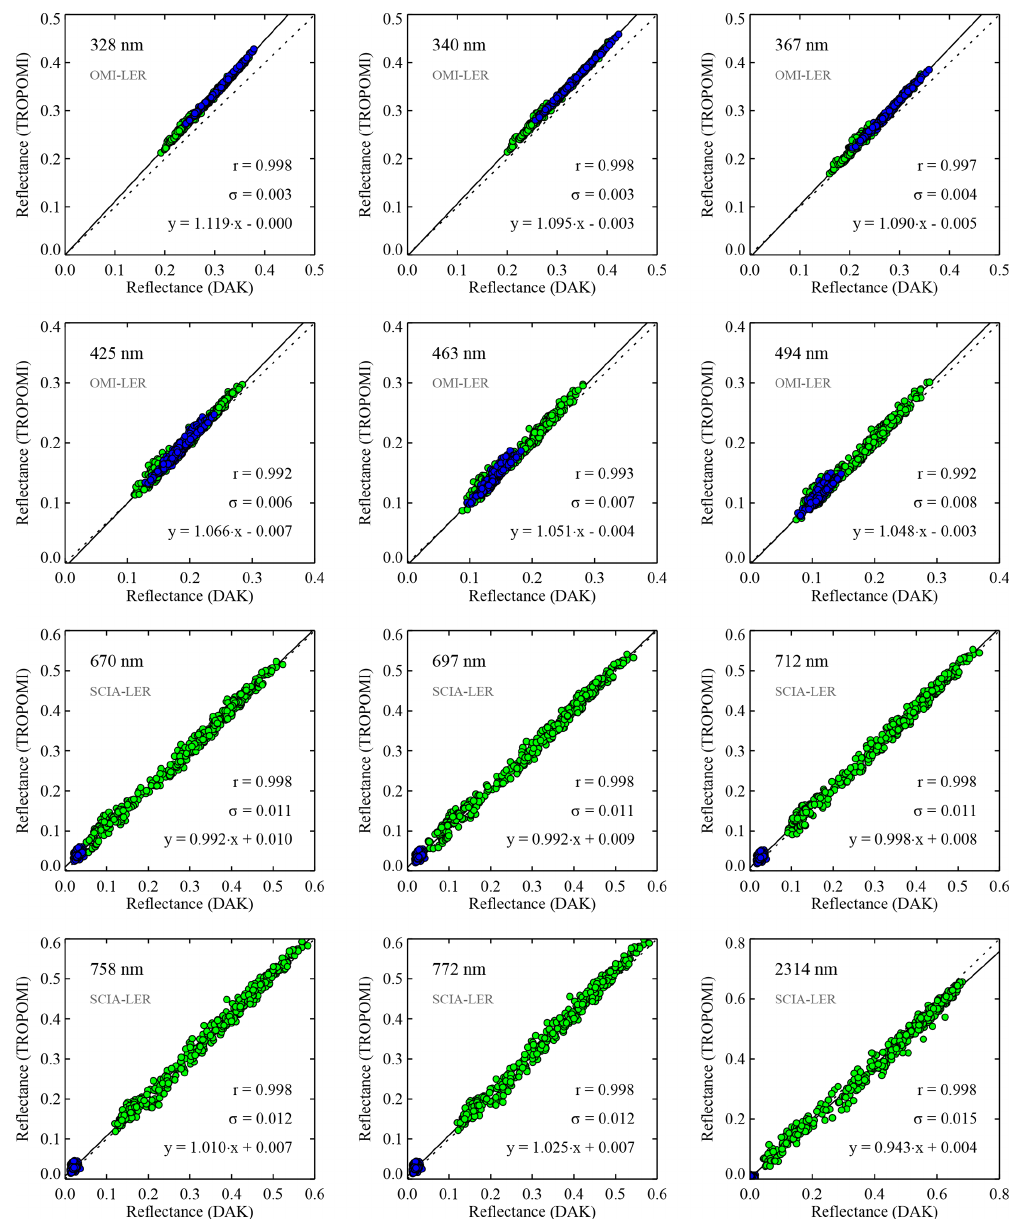
Figure 7. Reflectances measured by TROPOMI on 30 October 2019 versus simulated reflectances calculated using the DAK radiative transfer model, for 12 of the 21 wavelength bands studied in this paper. Only clear-sky observations were used in the scatterplots. As before, green circles represent clear-sky scenes over land, and blue circles correspond to clear-sky water scenes. For the wavelength bands below 500nm, the surface albedo is taken from the OMI surface LER database; above 500nm surface albedo input from the SCIAMACHY surface LER database is used. The analysis was performed using Method 4. The black lines represent linear fits y = m · x + n to the data. The fit results for m and n and the standard deviation σ of the data points w.r.t. the linear fit are shown in each